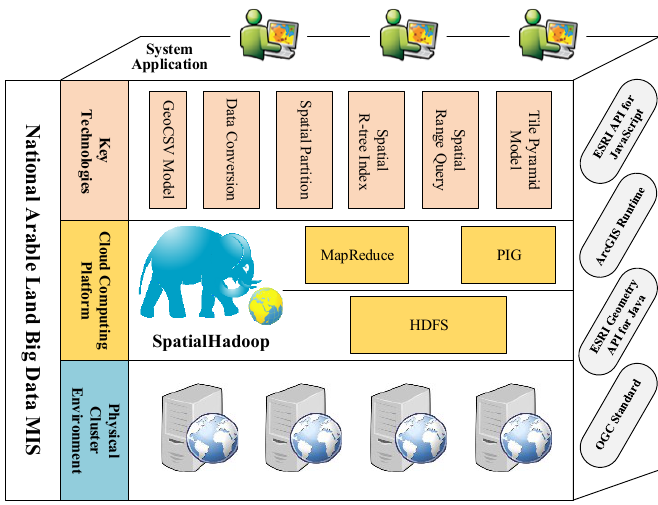
Figure 1. The LandQ v2 system overview.